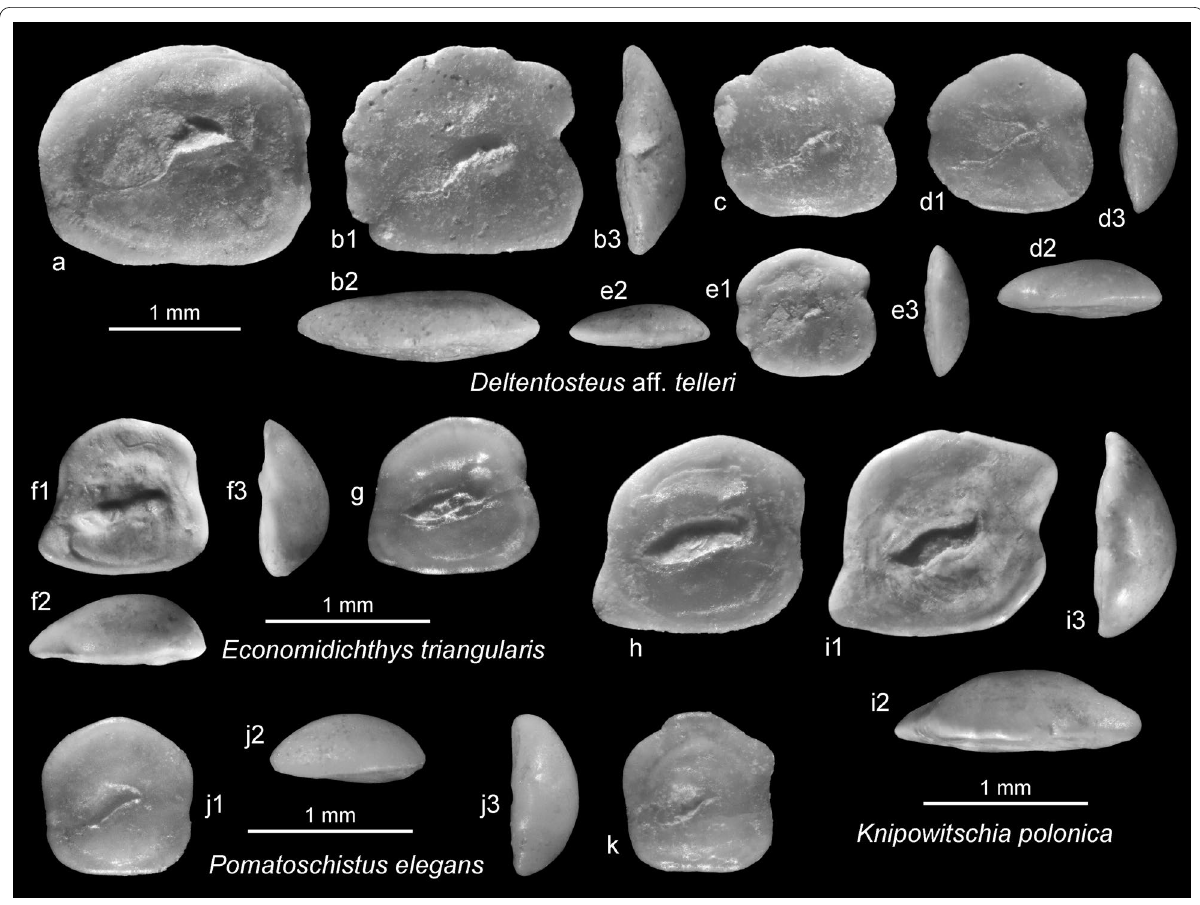
Fig. 7 Otoliths of Gobionellidae: a – e Deltentosteus aff. telleri (Schubert, 1906), 7a Shydlivshchyna, NMNHU-P PI 2553, b (reversed), d Kozatskyi Yar, NMNHU-P PI 2552, c (reversed), e Mlyntsi, NMB P1209. f , g Economidichthys triangularis (Weiler, 1943), f (reversed) Shydlivshchyna, NMB P1210, g (reversed) Mlyntsi, NMNHU-P PI 2554. h , i Knipowitschia polonica Schwarzhans et al., 2020a, 2020b, h Shydlivshchyna, NMNHU-P PI 2562, i Kozatskyi Yar, NMB P1213. j , k Pomatoschistus elegans (Procházka, 1900), j (reversed) Kozatskyi Yar, NMNHU-P PI 2576, k (reversed) Shydlivshchyna, NMB